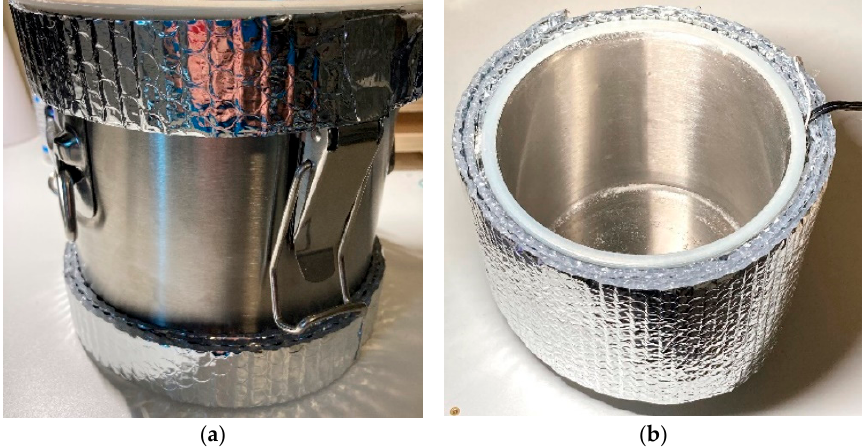
Figure 7. Install insulation on the chamber wall. ( a ) First, attach strips of insulation to build an air gap and span the protruding components on the chamber walls; ( b ) Next, install the large piece of insulation, fully covering the walls of the chamber.